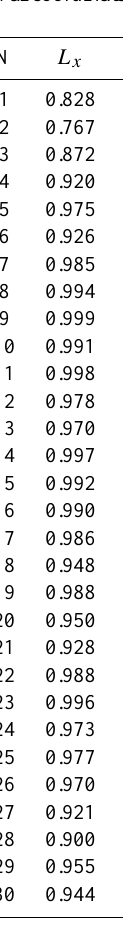
Table 2. Local normal coordinate system a .